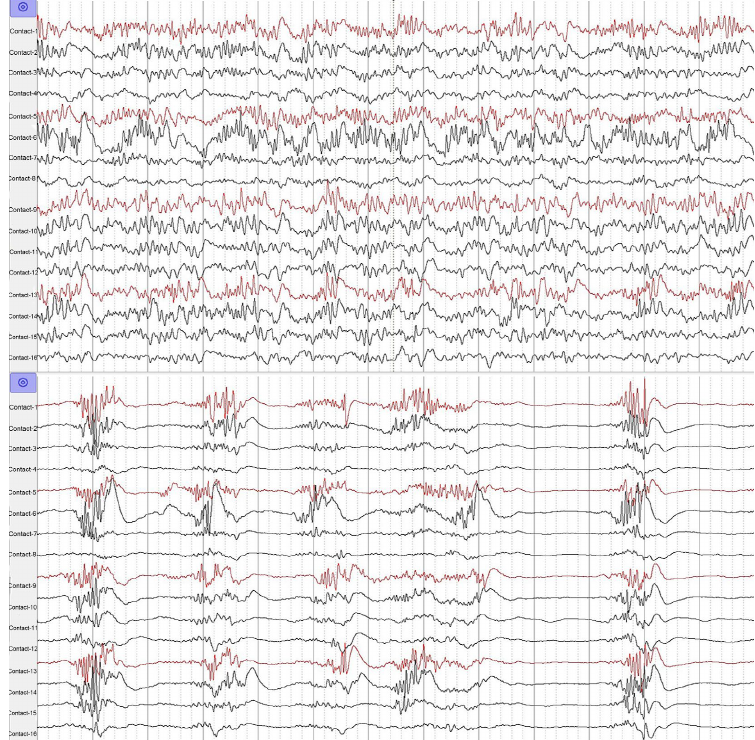
Figure 4. The low- dose propofol suppressed the background of ECoG